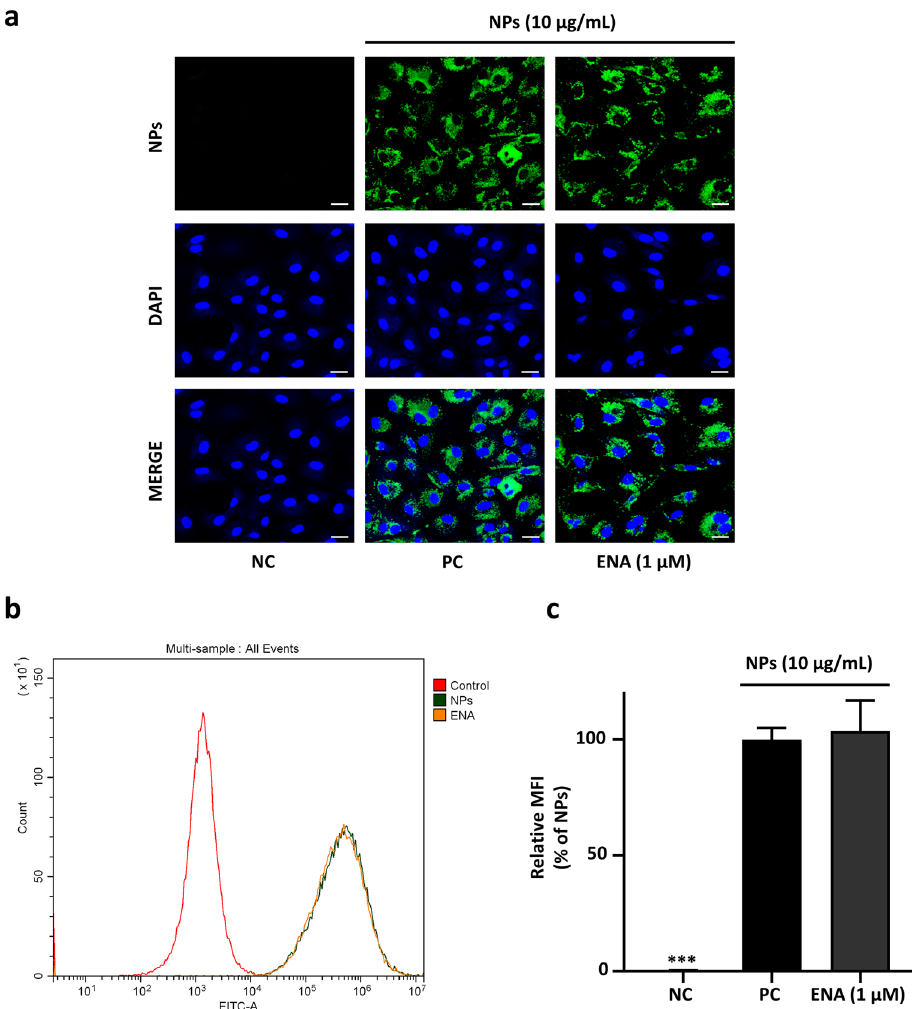
Figure 4. Enavogliflozin does not interfere with NPs uptake by PCAECs. ( a ) Representative confocal microscopy images of NPs internalization in PCAECs treated with or without NPs (10 μg/mL) alone and with ENA (1 μM) for 24 h. DAPI: diamidine-2-phenylindole dihydrochloride; MERGE: the merged image of NPs + DAPI; scale bar = 20 μM. ( b ) Representative histogram of NPs internalization analyzed with flow cytometry; ( c ) The mean of three independent experiments is presented as the relative mean fluorescence intensity (MFI). The values were normalized against the MFI of PC as a reference. The mean fluorescence intensity indicates the accumulation of NPs in cells. Data are the mean ± SEM (n = 3). *** p < 0.001 versus PC (complete media + NPs 10